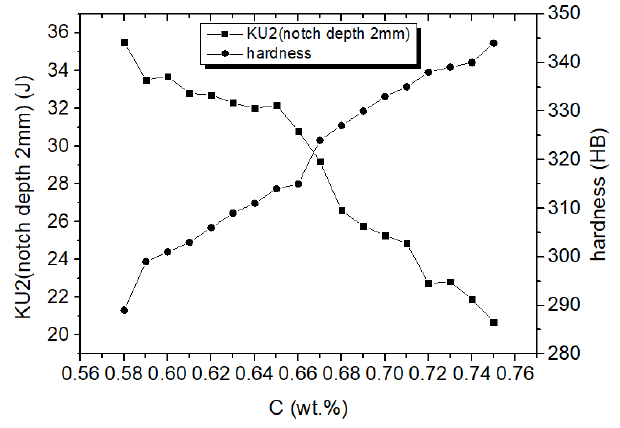
Figure 6. Rim impact varies with C content.